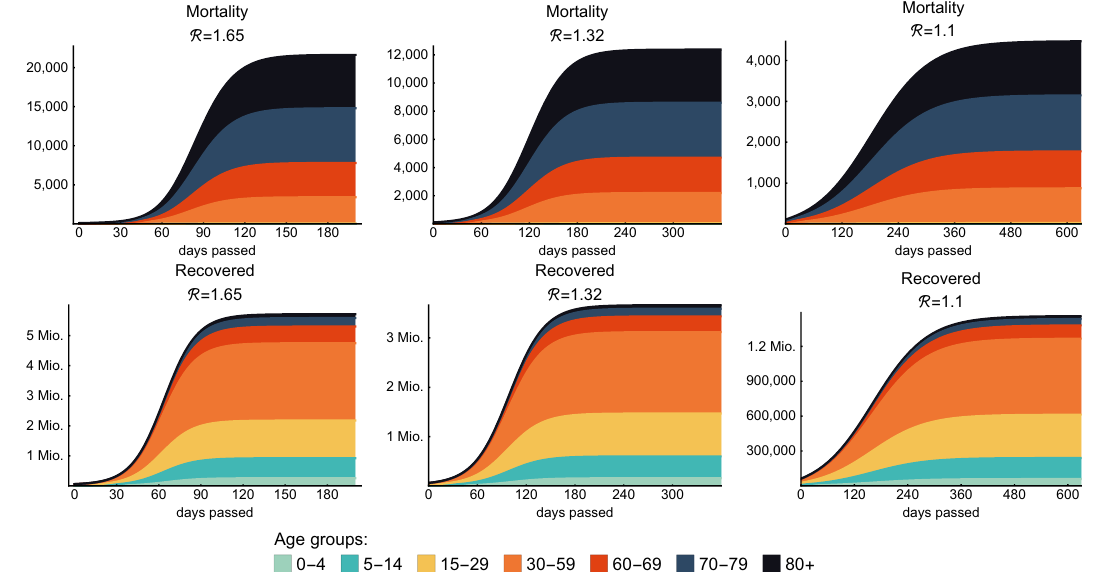
Figure 9. Age-specific mortality and recovery. The figure shows the effect of the weak, moderate, and strong control (25%, 40% and 50% general contact reduction, respectively). Every age group covers at most one decade except the group of “middle aged” that represents three decades. According to our model, elderly people (60+) are predicted to produce most of the fatality cases in each scenario. The legend on the bottom applies for all